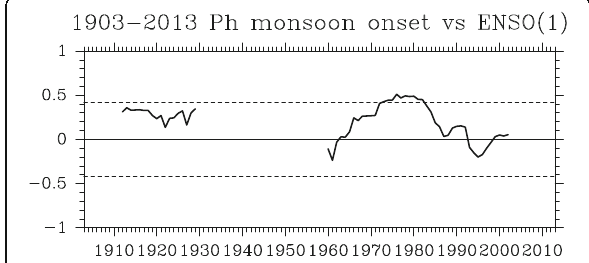
Fig. 7 Correlation between ENSO and Philippine monsoon onset date. Twenty-one-year running correlation between Niño 3.4 SST av- eraged during the preceding December to February and Philippine monsoon onset date. Dashed lines indicate the 95% confidence level